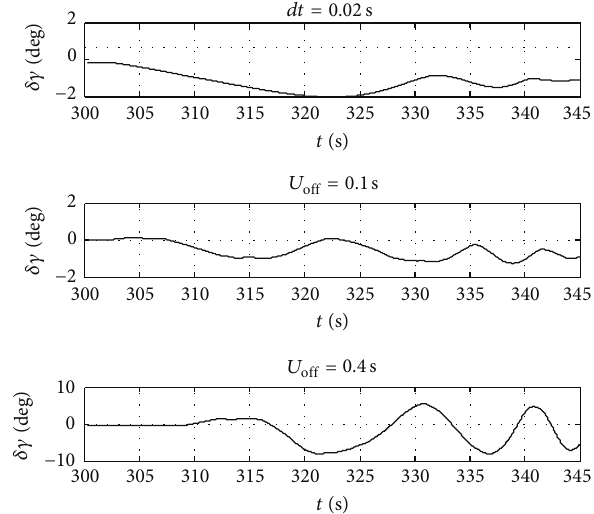
Figure 34: Simulation result of roll angle deviation.